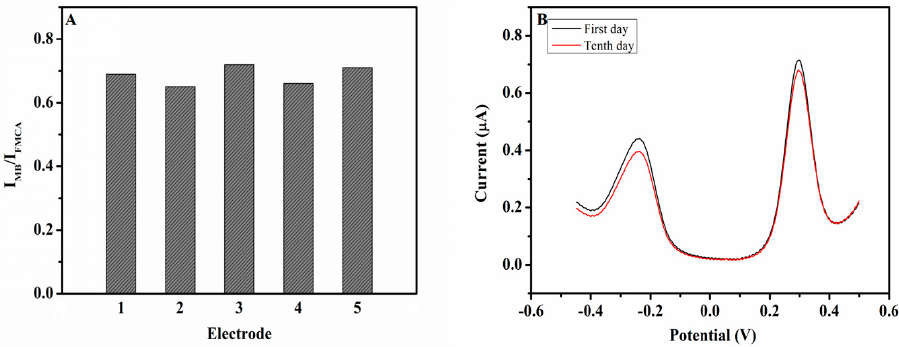
represent five independent electrodes, respectively. ( B ) Stability of the aptasensor for 0.154 μ g/mL